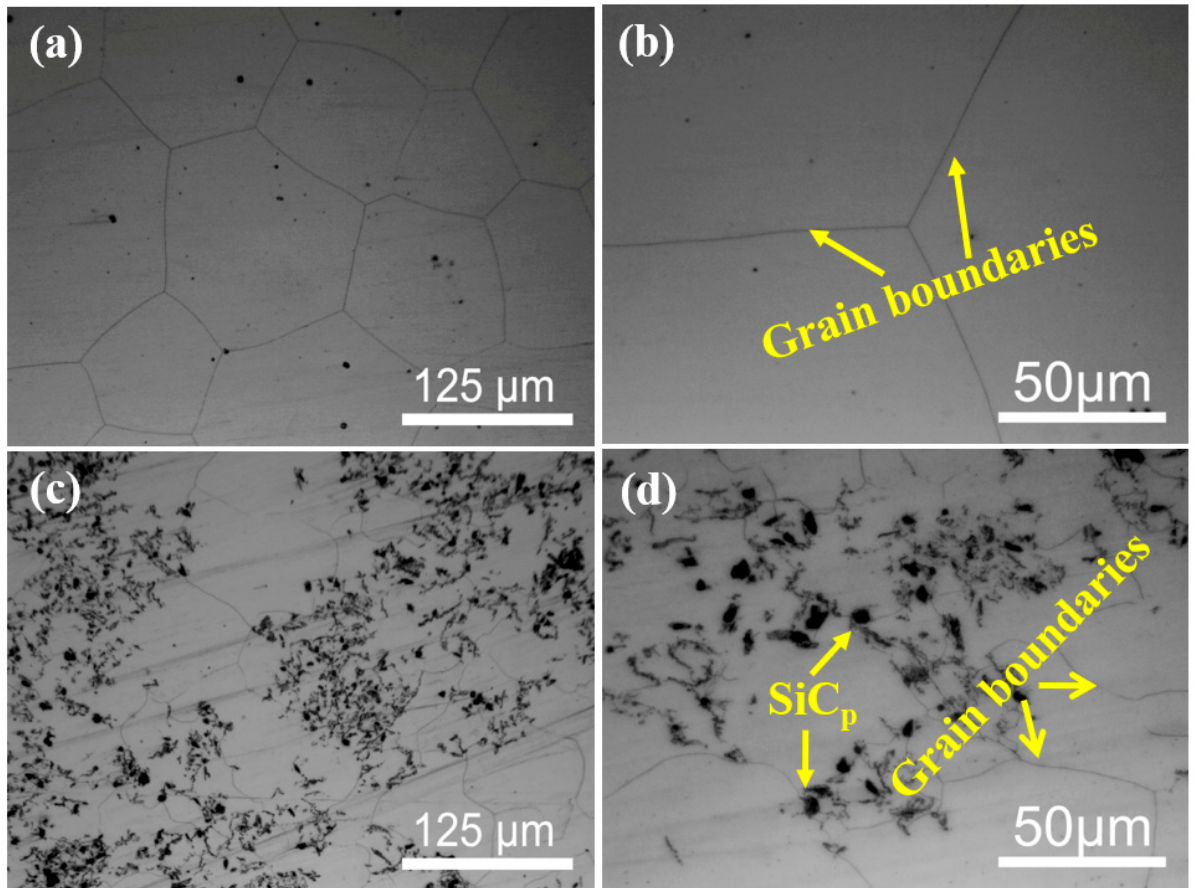
Figure 1. OM microstructure of as-homogenized ( a , b ) Mg-5Zn alloy and ( c , d ) SiC p /Mg-5Zn material.